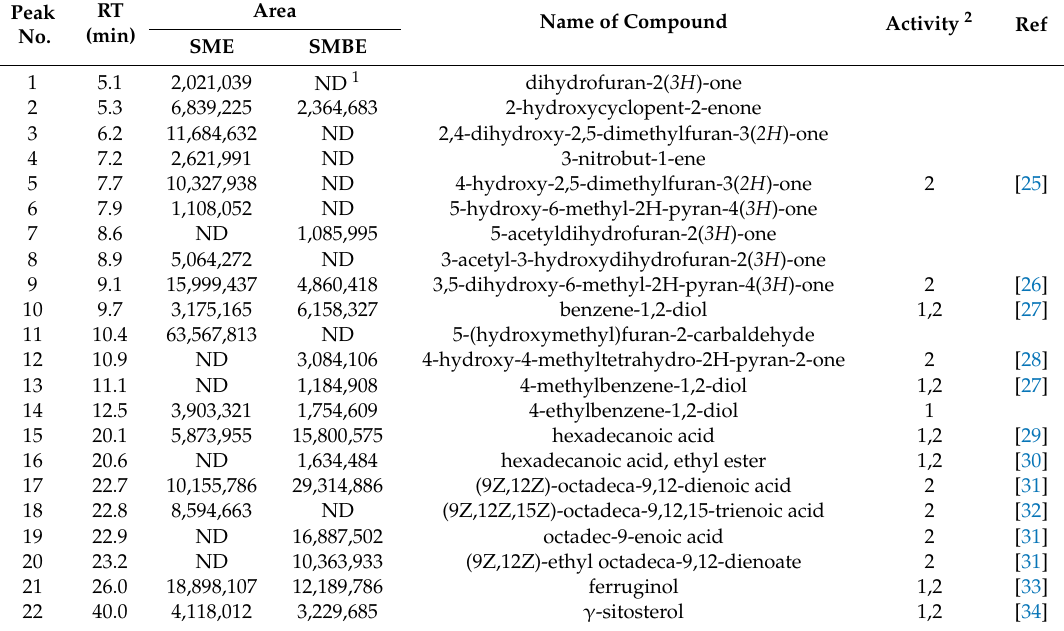
Table 5. Compounds detected by GC-MS analysis of S. miltiorrhiza ethanol extracts. Peak No.